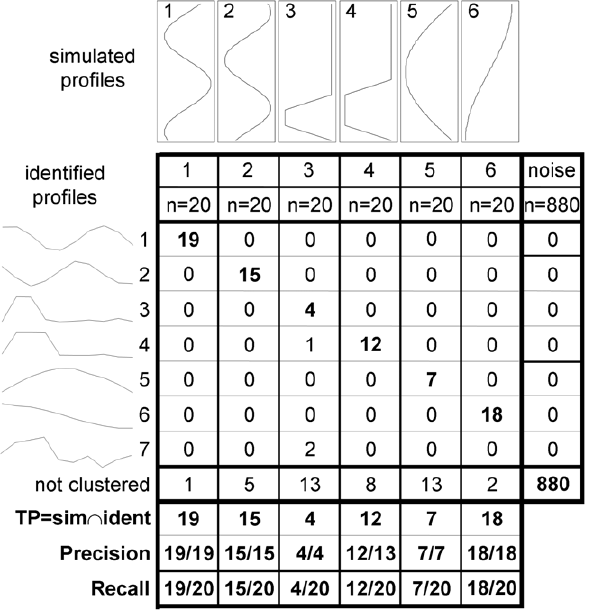
Table 1. Results of the clustering on simulated data.